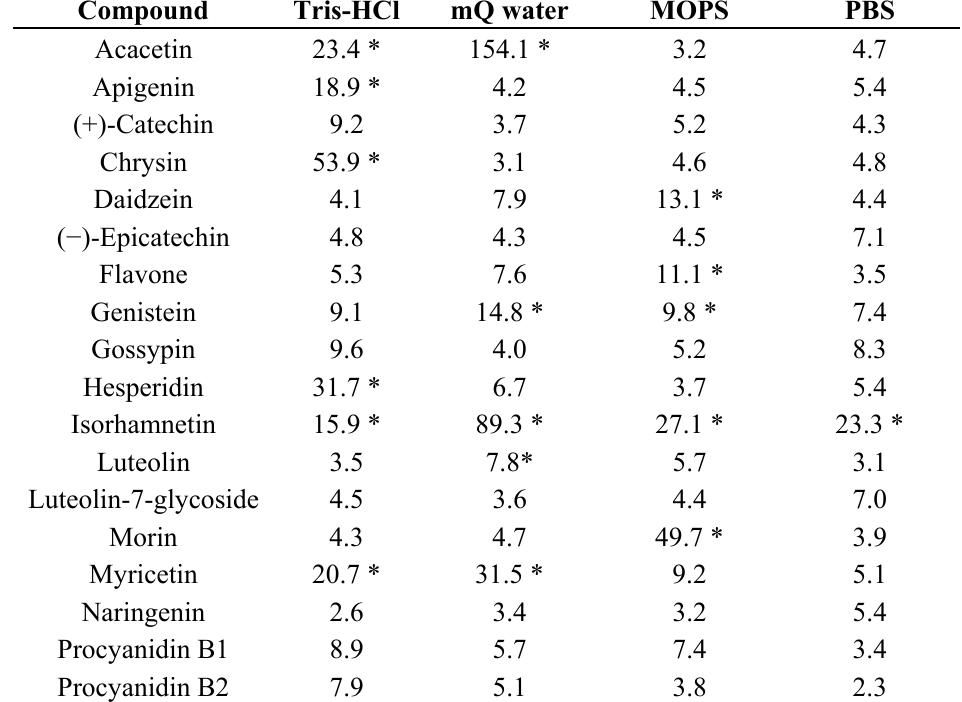
Table 2. DLS Scattering intensities (kCounts) of selected flavonoids in different buffers a